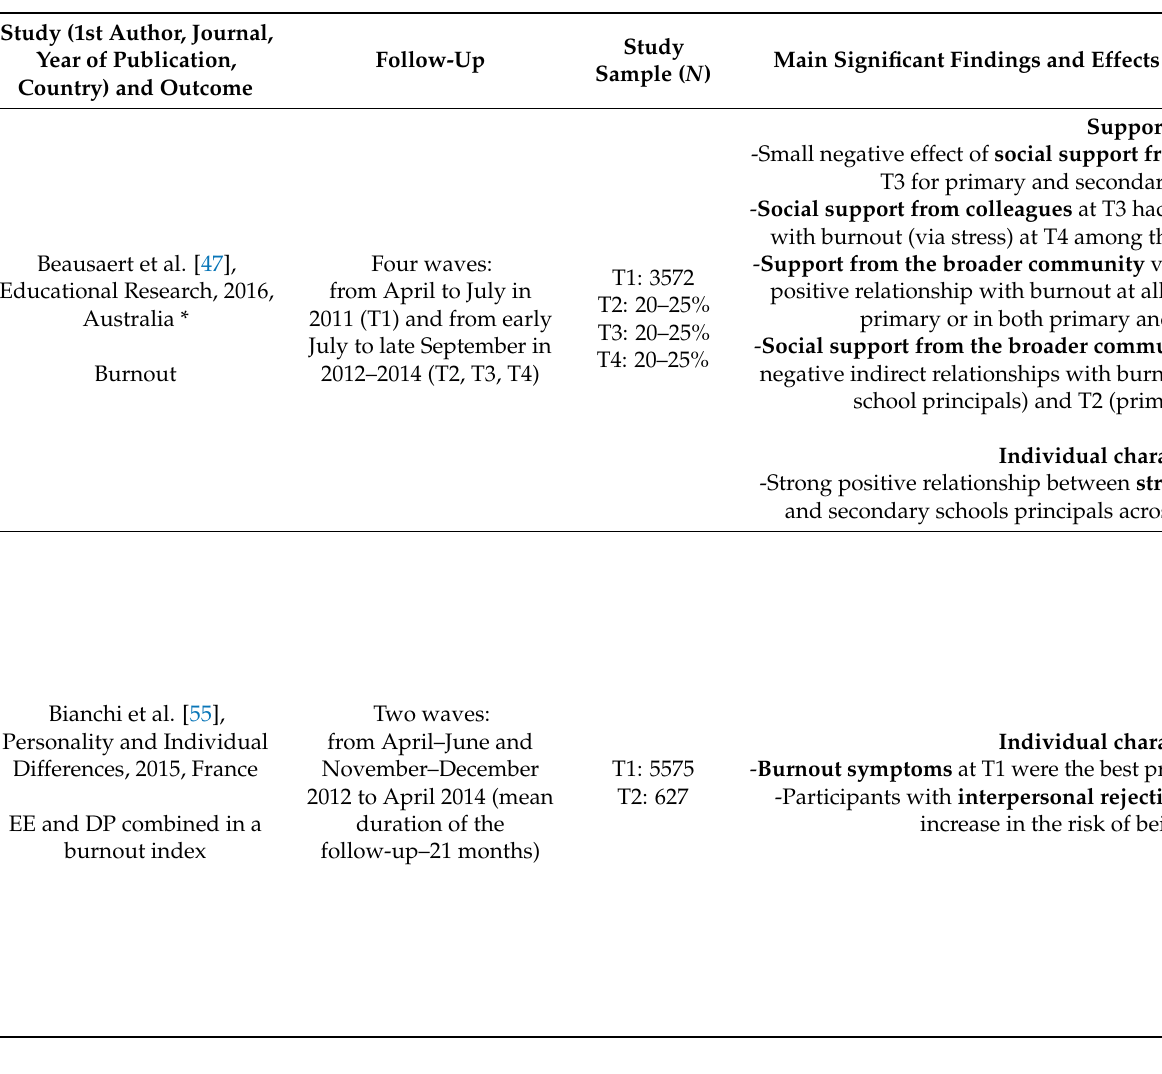
Table 1. Characteristics of studies on burnout among teachers ( n =